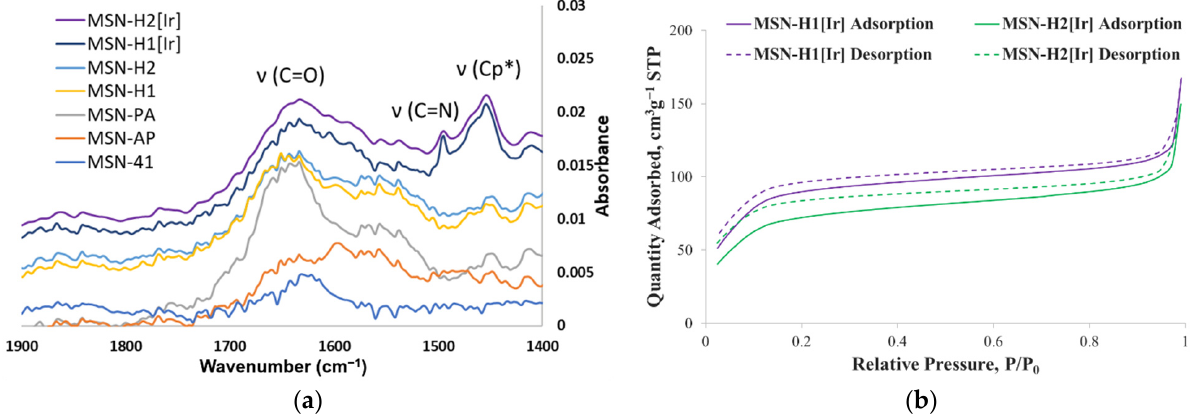
Figure 2. SEM images of ( a ) MSN-H1[Ir] and ( b ) MSN–H2[Ir]. Table 1. Hydrodynamic radius and zeta potential of prepared nanomaterials *.